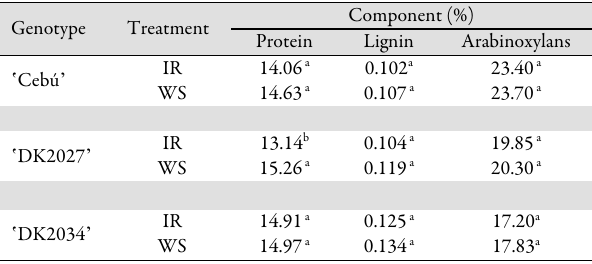
Table 1. Effect of water stress on protein, lignin and arabinoxylans in the studied maize hybrids Genotype